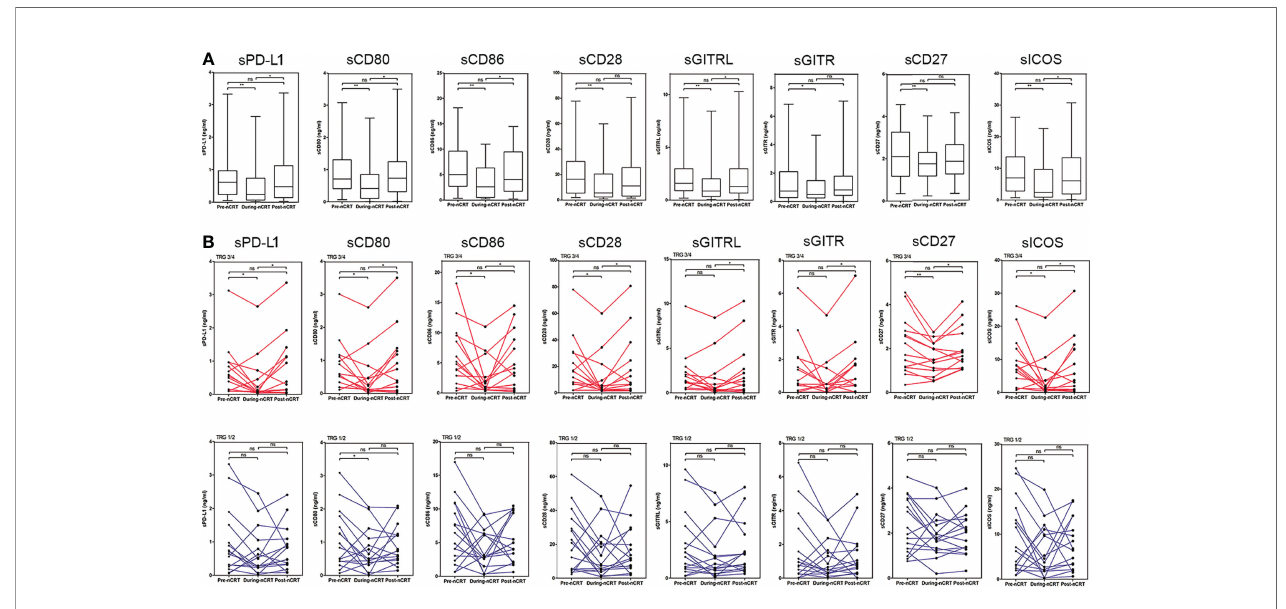
FIGURE 2 | Changes in sPD-L1, sCD80, sCD86, sCD28, sGITR, sGITRL, sCD27, and sICOS levels following chemoradiotherapy. (A) Overall changes in all patients. (B) Individual changes in the good responders (TRG3/4 group) and the poor responders (TRG1/2 group).*p < 0.05, **p < 0.01, ns, not signi fi